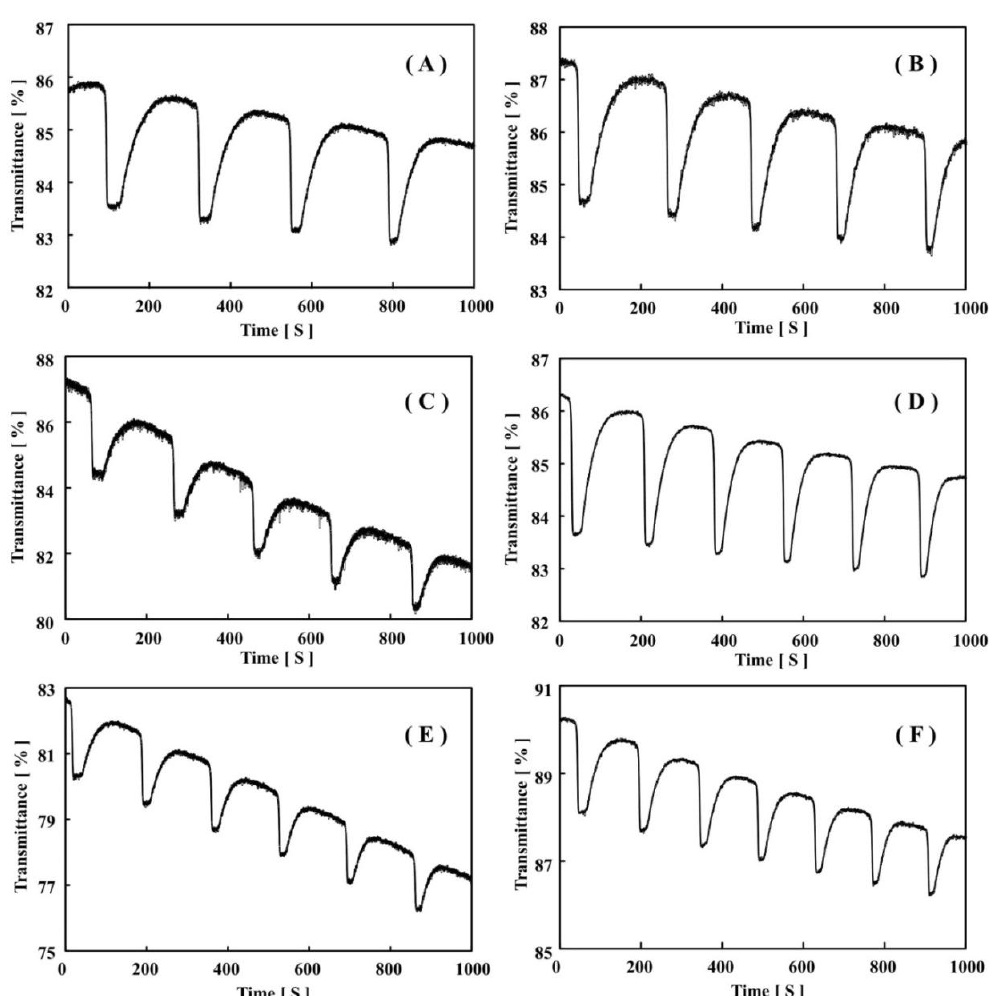
Figure 5. Oscillating transmittance profiles at 14 °C for 0.5 wt% poly(VP- co -Ru(bpy) solution at fixed nitric acid and sodium bromate conditions ([HNO [NaBrO ] = 0.3 M) and with ( A ) [MA] = 0.04 M, ( B ) [MA] = 0.05 M, ( C ) [MA] = 0.06 M, 3 ( D ) [MA] = 0.07 M, ( E ) [MA] = 0.08 M, and ( F ) [MA] = 0.09